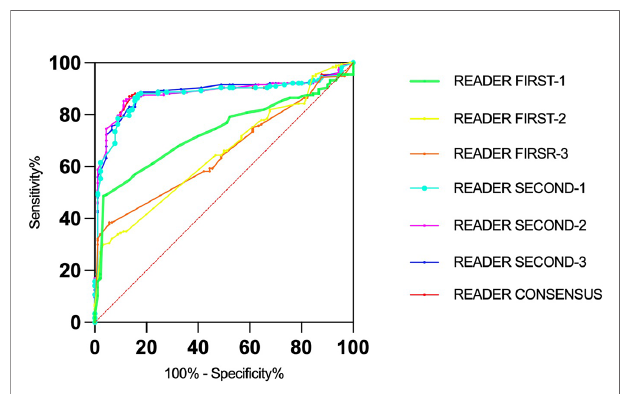
FIGURE 2 | Receiver operating characteristic (roc) curves for the senior and junior readers